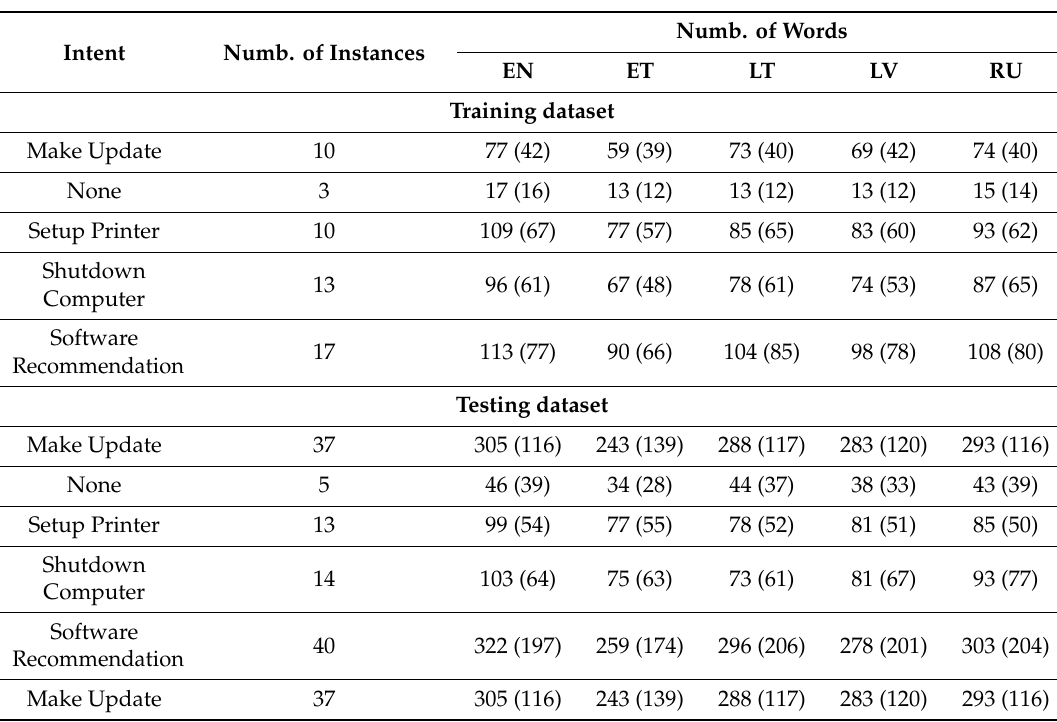
Table 2. Statistics about the askUbuntu